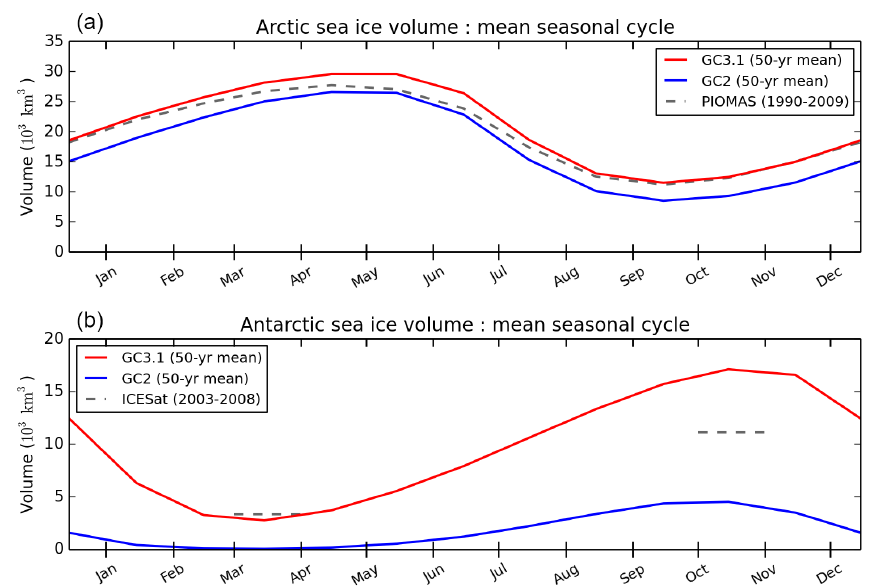
Figure 5. The HadGEM3 model annual cycle of sea ice volume in the Arctic (a) and Antarctic (b) . Volume estimates from the PIOMAS model reanalysis are included for the Arctic and ICESat estimates of volume in the Antarctic (grey dashed lines).